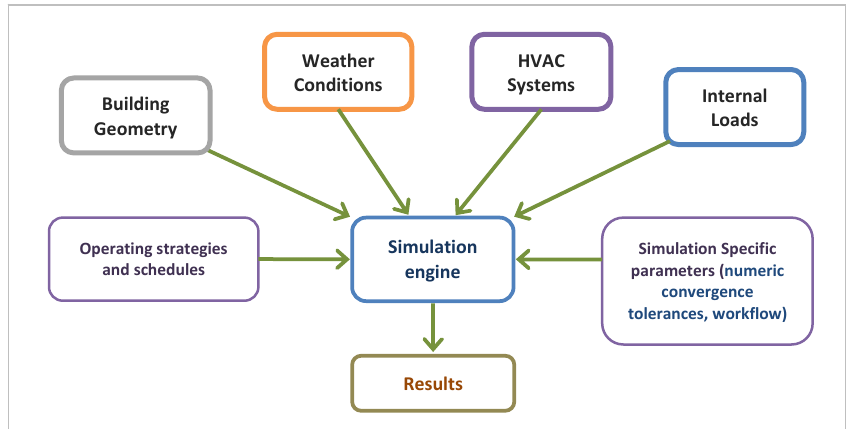
Figure 1. General input data of thermal simulation engines